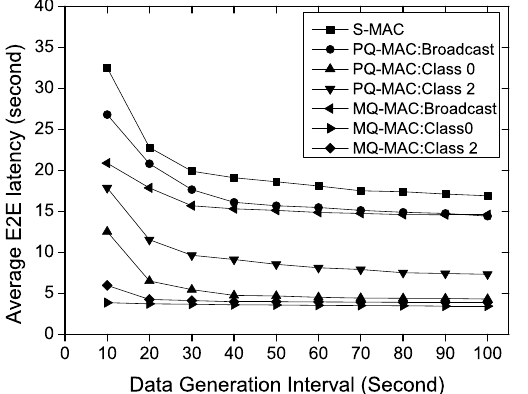
Figure 7. Average E2E latency varying data generation interval.